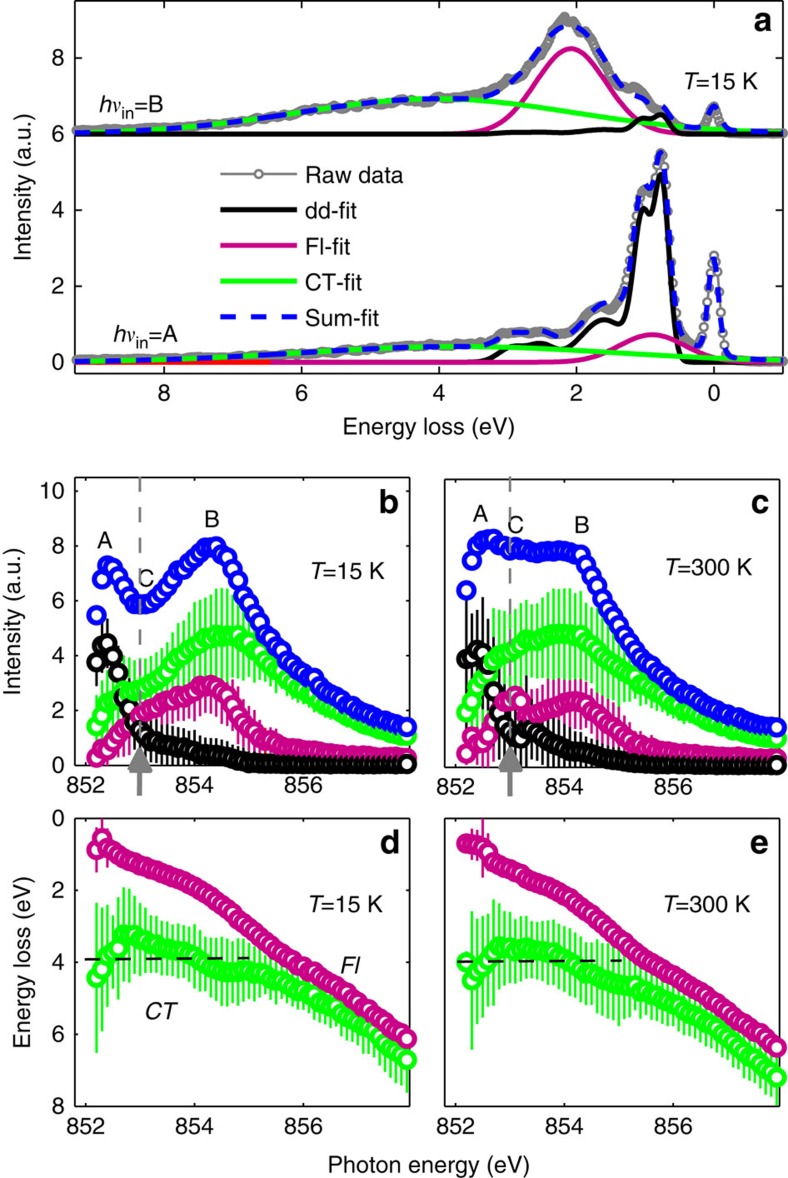
RIXS data analysis across the MIT.(a) RIXS line spectra (grey open-dot line) measured at hνin=A and hνin=B at 15 K. The thin solid lines refer to Gaussian fits of dd-excitations (black), the CT excitation (green) and the Fl excitation (magenta). The blue-dashed line refers to the sum of the three fitting contributions, plus the elastic line at 0 eV. (b,c) Integrated intensity of the fit dd-, CT- and Fl-excitations together with the total integrated intensity at 15 K (300 K). The grey arrow marks the incident energy giving the most pronounced changes in the RIXS integrated intensity across the MIT. (d,e) Peak energy dispersion for the CT- and Fl-excitation at 15 K (300 K). The same colour code as in a is used throughout the figure. The error bars of the model parameters are evaluated using the least square fitting routine and expressed in s.e.d. The error bars of the initial RIXS spectra were estimated assuming Poisson statistics.